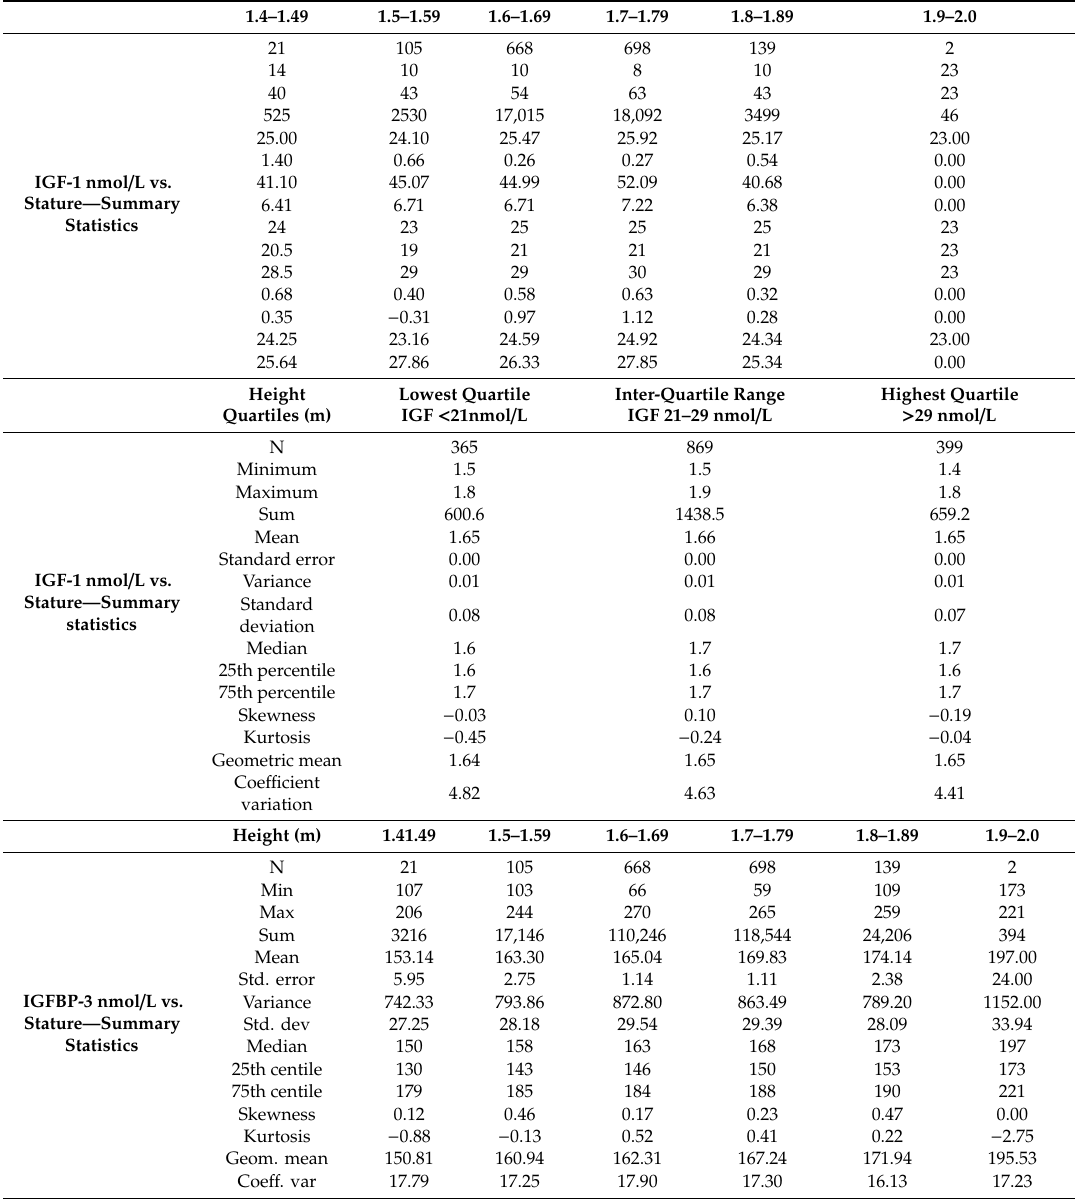
Table 4. Summary statistics are shown for the 1633 women with IGF profiles stratified according to their stature and depicted in Figure 5. The IGF-1 levels are shown for six height categories ranging from 1.4 m to 2.0 m in as well according to their centile ranges in Table 4. Similarly, the IGFBP-3 levels are shown for the six height categories ranging from 1.4 m to 2.0 m as well as according to their centile ranges in Table 4. Finally, the IGFBP-3 / IGF-1 ratios are shown for the six height categories ranging from 1.4 m to 2.0 m as well as according to their centile ranges in Table